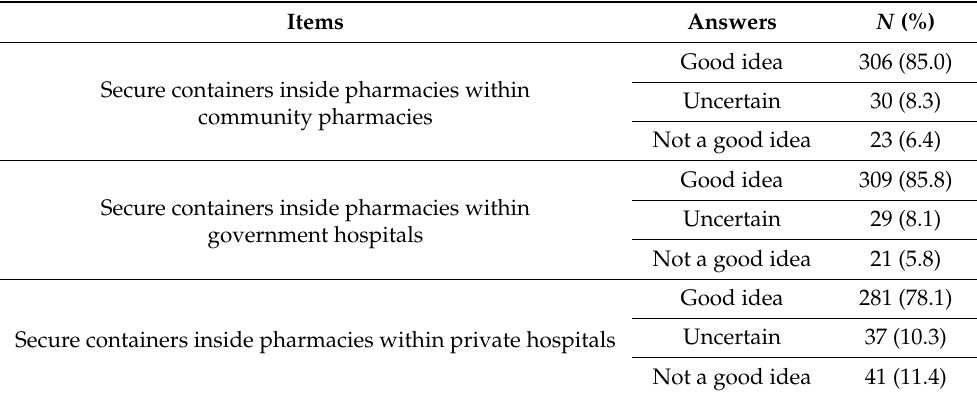
Table 4. Beliefs of community pharmacists about the appropriate location for collecting unused